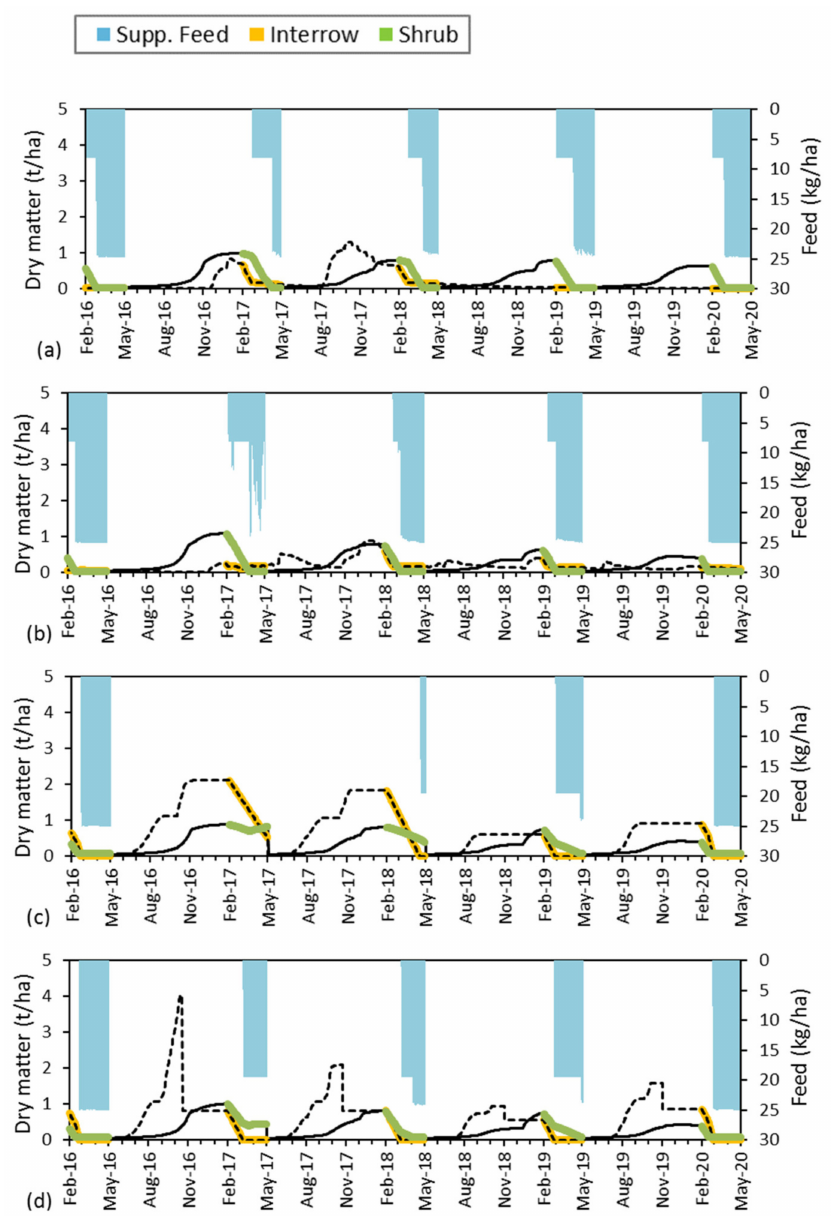
Figure 5. Daily change in dry matter (kg/ha) available to animals in the shrub-row (solid line and during the grazing period green shading) and interrow (segmented line and during the grazing period yellow shading) based on APSIM saltbush grazing model with short-term grazing at Waitchie for ( a ) medic, ( b ) panic, ( c ) unharvested oats, and ( d ) harvested barley. The blue columns indicate supplementary feed. The yellow shading of the segmented line indicates periods when grazing occurred. All plants were reset to a common threshold at the end of the grazing